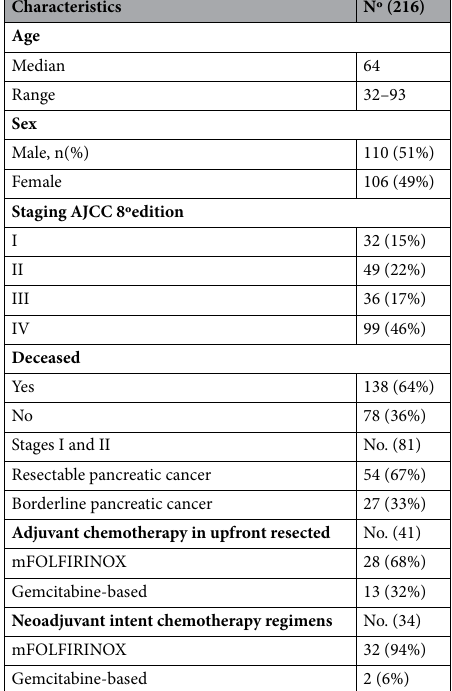
Table 1. Clinical demographics of overall population. AJCC American Joint Committee on Cancer, mFOLFIRINOX fluorouracil, oxaliplatin and irinotecan.